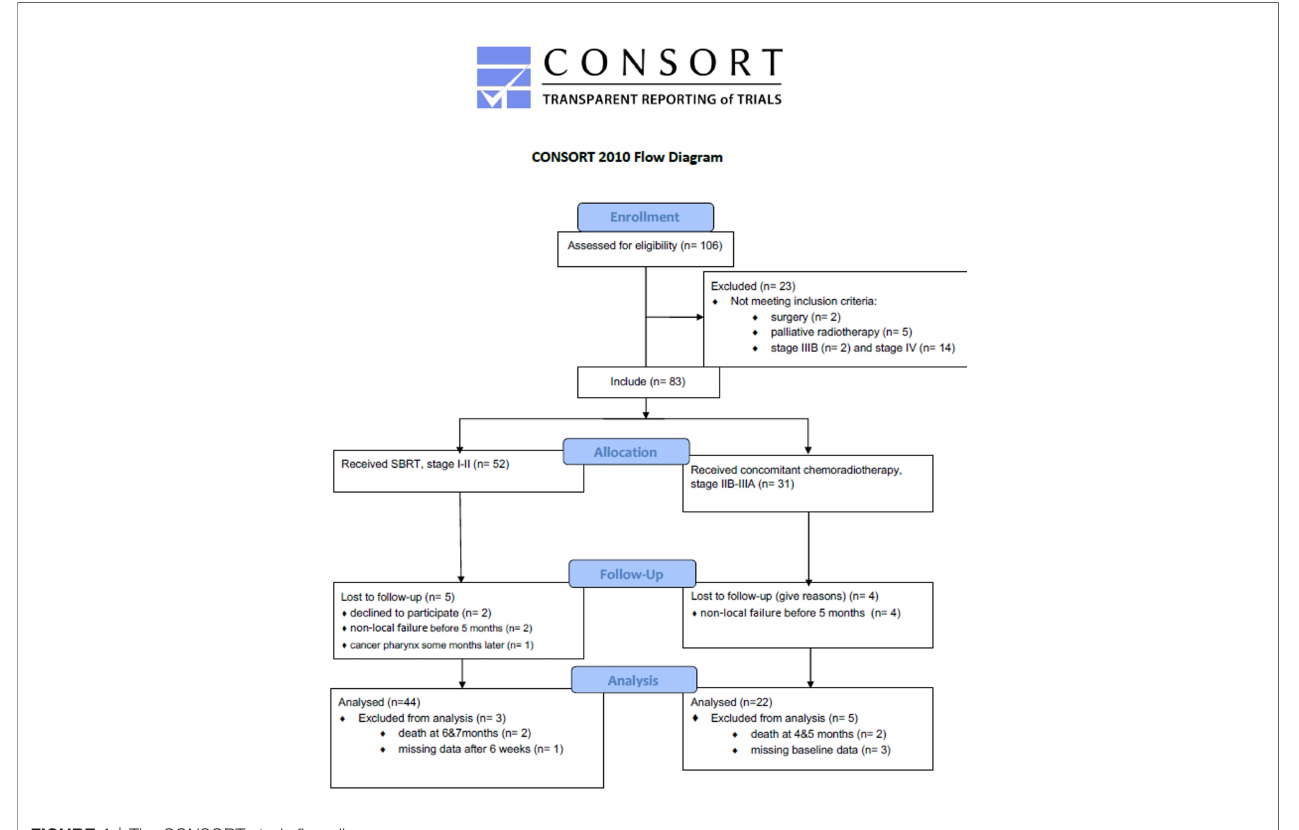
FIGURE 1 | The CONSORT study fl ow diagram.